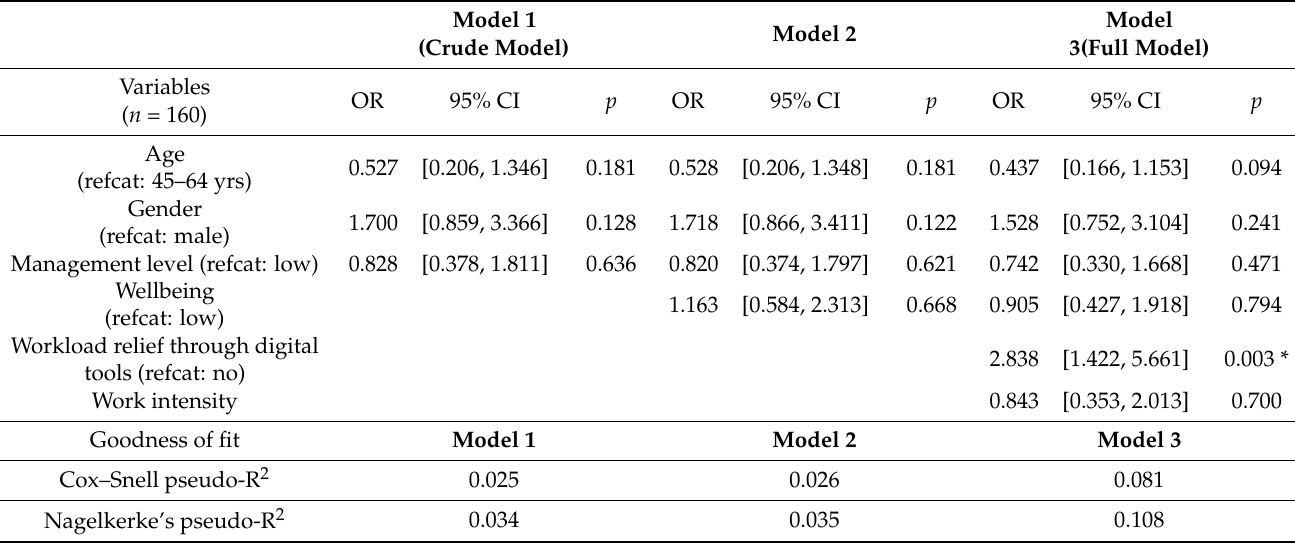
Table 2. Progressively Adjusted Logistic Regression Models for Variables Associated with Managers’ Previous HPM Participation ( n =